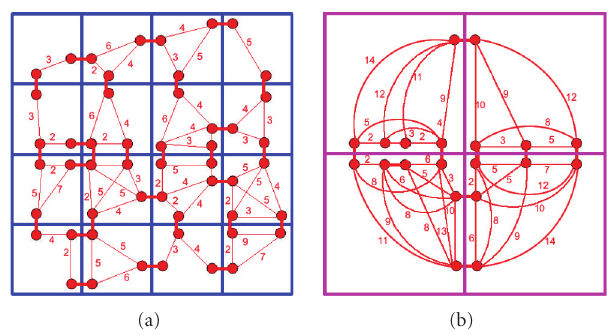
Figure 13: Path smoothing with cost 27.